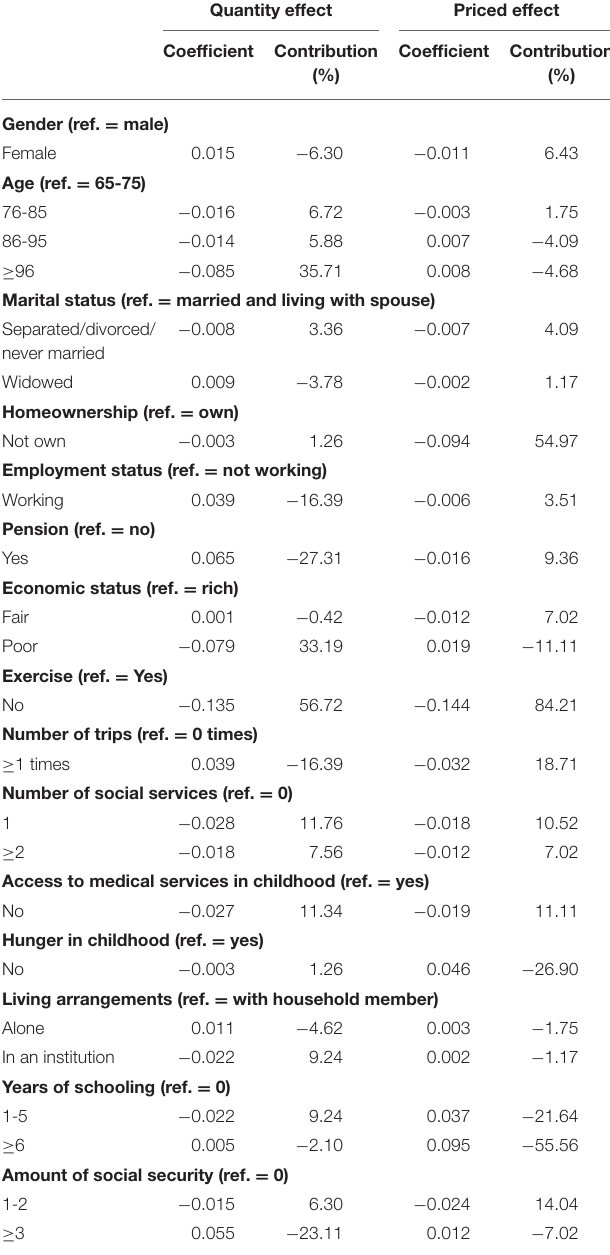
TABLE 4 | Quantity and priced effects of explanatory variables on the change in urban-rural disparity in cognitive